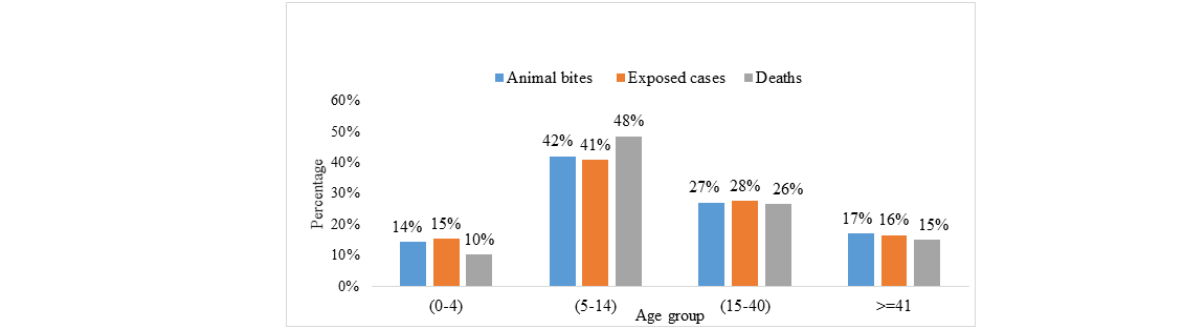
Available quantities of rabies vaccine and immunoglobulins